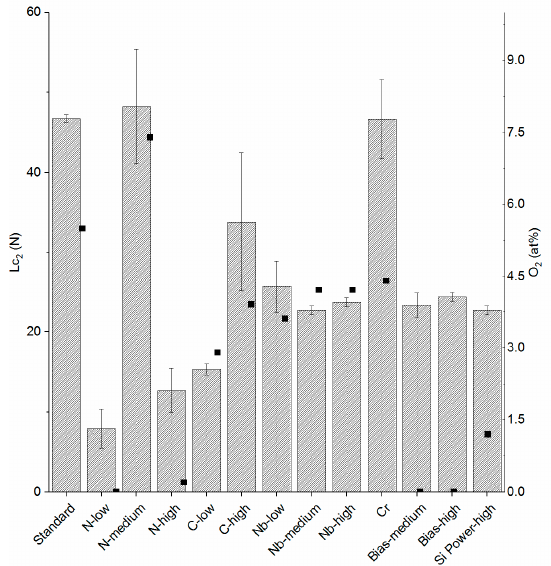
Figure 2. On the left axis the results for adhesion (Lc 2 ) are shown for the coatings tested in this study, with bars and standard deviations. On the right axis the O 2 content of the coatings is shown, represented by square dots.